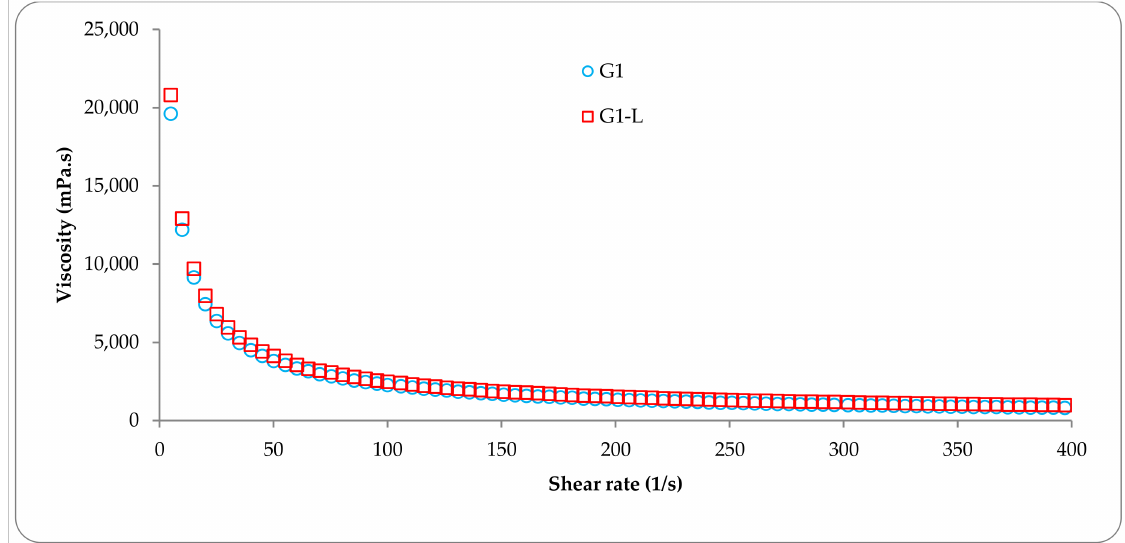
Figure 2. Variation of the apparent viscosity as a function of the shear rate at 37 ◦ C.